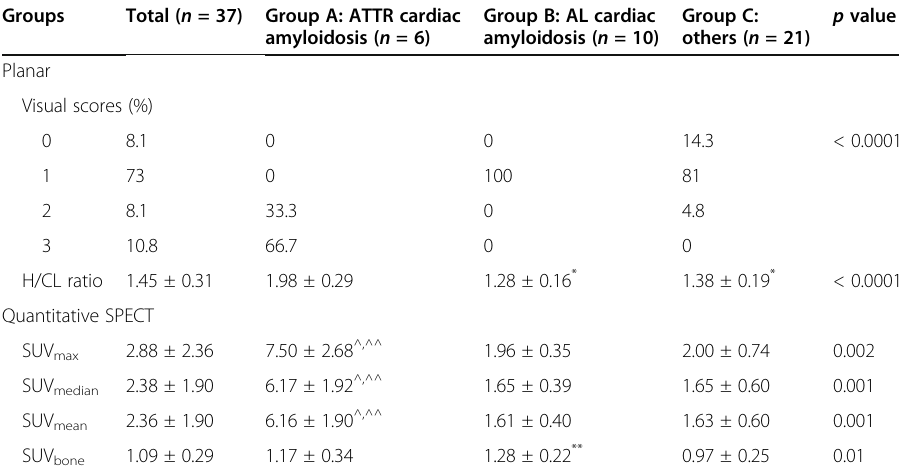
Table 2 99m Tc-PYP findings from planar and quantitative SPECT Groups Total ( n = 37) Group A: ATTR cardiac amyloidosis ( n =